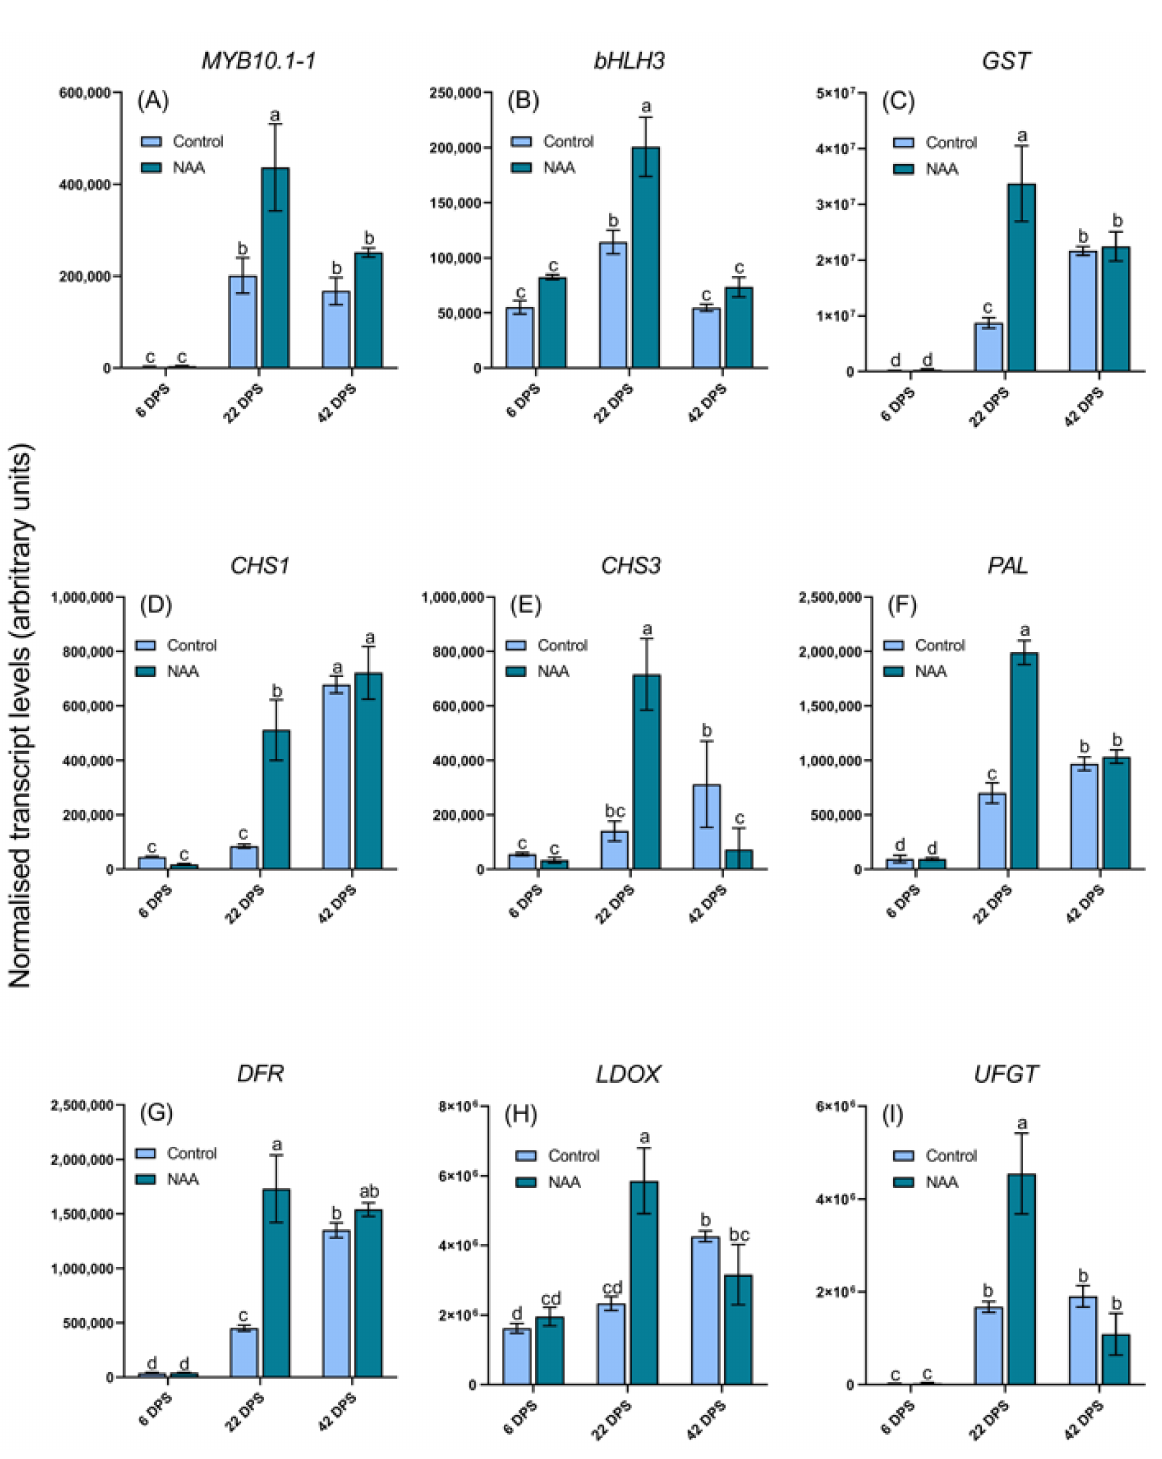
Figure 2. qRT-PCR analysis of anthocyanin regulatory genes in sweet cherry ( Prunus avium L.) fruit at three timepoints after the pre-ripening application of 100 mg/L NAA. ( A ) MYB10.1-1 p < 0.0001, ( B ) bHLH3 p < 0.0001 and anthocyanin structural genes ( C ) GST p < 0.0001, ( D ) CHS1 p <0.0001, ( E ) CHS3 p < 0.0001, ( F ) PAL p < 0.0001, ( G ) DFR p < 0.0001, ( H ) LDOX p < 0.0001 and ( I ) UFGT p < 0.0001. All data represent geometric means ± s. e. ( n = 3), bars are denoted by a different letter (a, b, c, d, bc, cd) if the means differ significantly using one-way ANOVA followed by Waller-Duncan’s post hoc test. DPS = days post